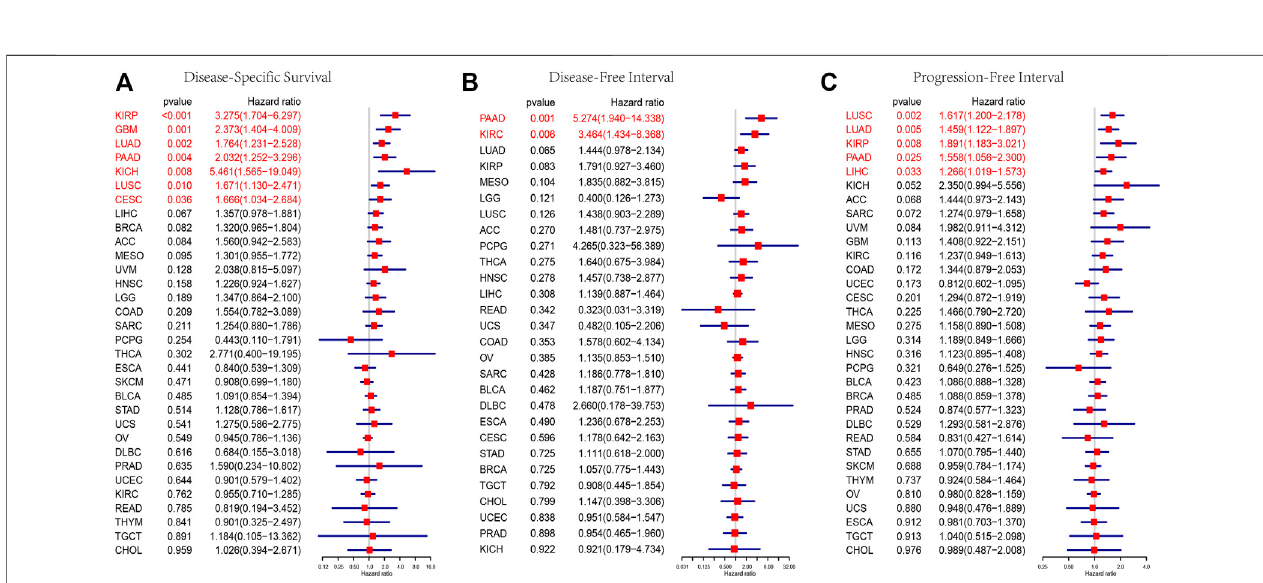
FIGURE 5 | Prognostic value of AP3S1. Forest plots showing results ofUnivariate Cox Regression analysis for (A) DSS, (B) DFI, and (C) PFI. Red color represents signi fi cant results ( p < 0.05).